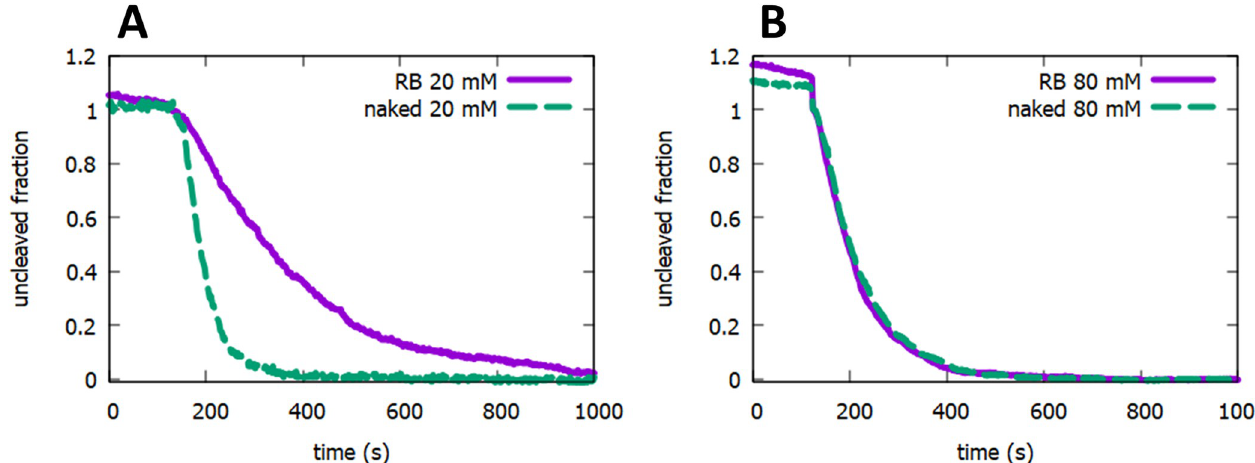
Fig 3. Effect of roadblocks on DNA translocation. Cleavage by NdeI under target search limiting conditions for both naked (dashed green curve) and roadblocked (solid purple) DNA is shown. (A) 20 mM NaCl. Target search relies on extensive translocation events and roadblocks have significant effect. (B) 80 mM NaCl. Target search makes use of short translocation events and roadblocks have no effect. Data is scaled in each case so that the uncleaved fraction is one at time of NdeI injection (180s).